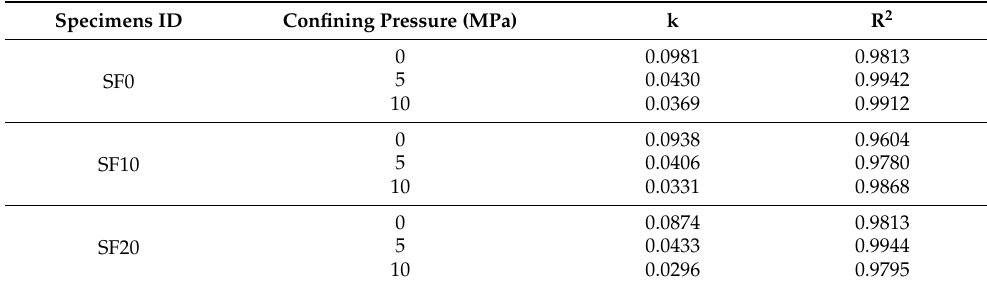
Table 5. Classification of CaCO 3 produced by microorganisms and its suitable environmental conditions in concrete structures.